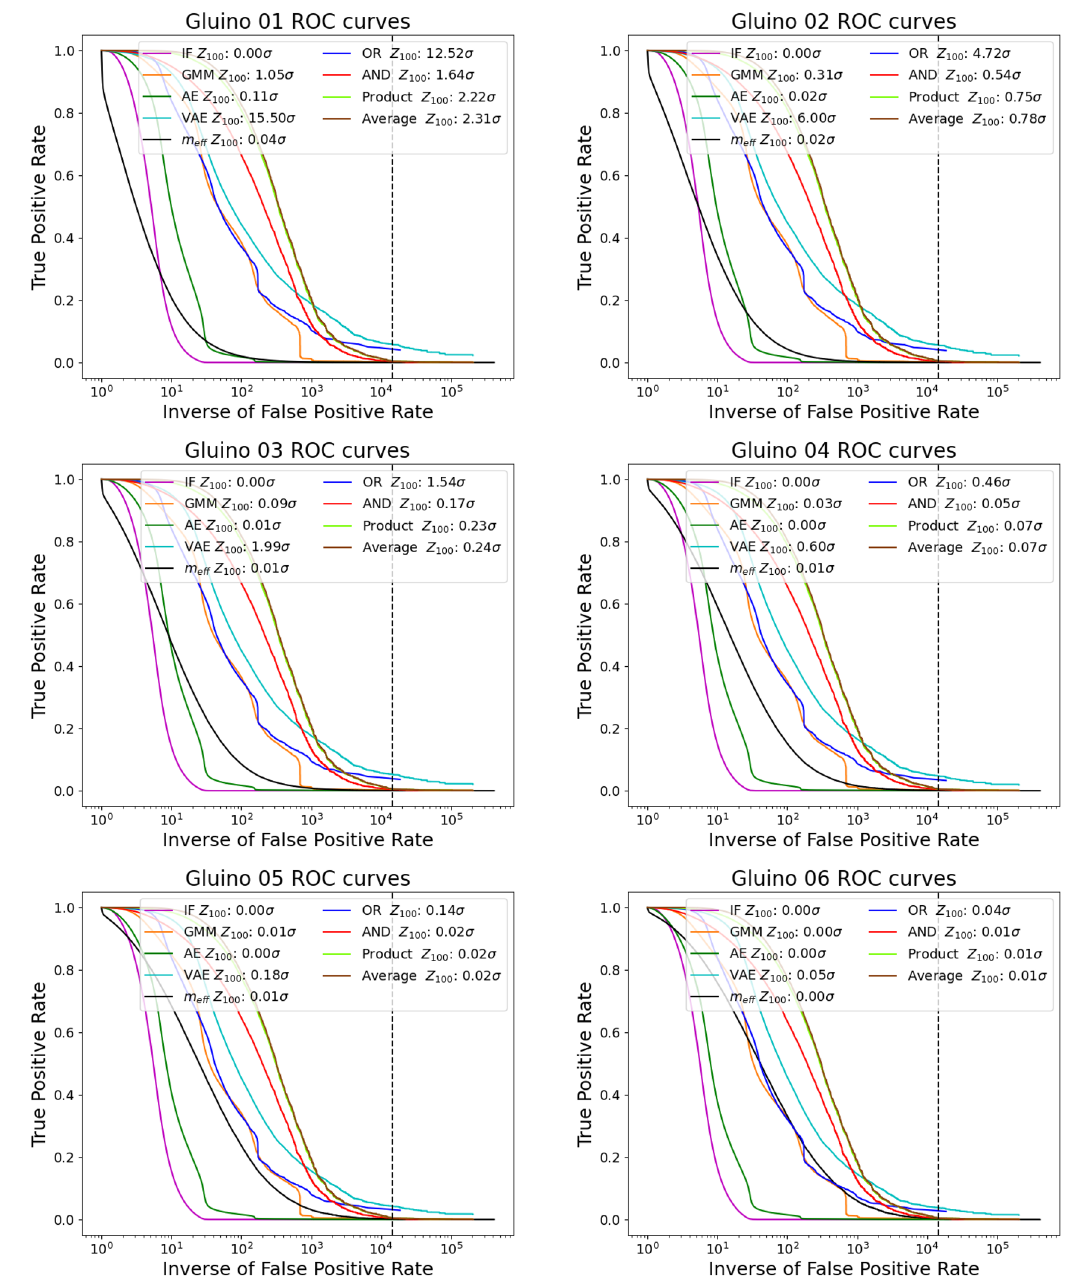
Figure 3 . ROC curves for the gluino signals (table 1) for the algorithms applied on 4-vector representations, with on the horizontal (vertical) axis the inverted false-positive (true-positive) rate. The ROC curves of IF, GMM, AE and VAE (table 3) are shown in pink, orange, dark green and cyan respectively. The effective mass m is shown in black, and combinations of the models eff are shown in blue (OR), red (AND), light-green (Product) and brown (Average). The black dashed line indicates the inverse false-positive rate at which B = 100